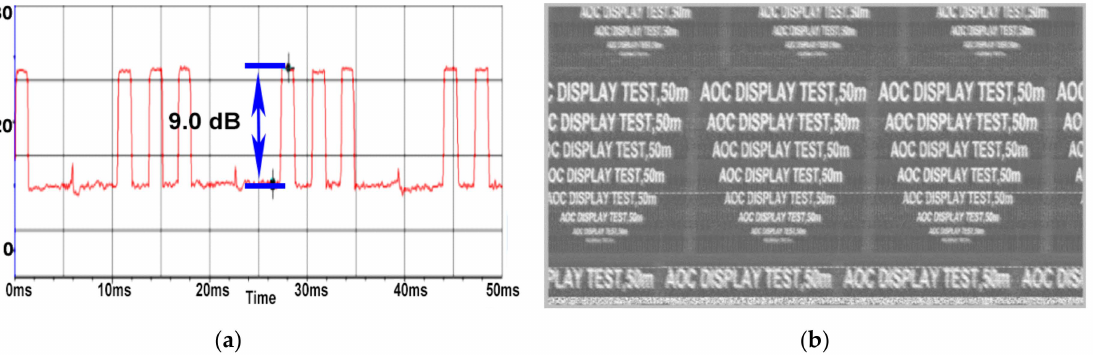
Figure 13. AOC display: ( a ) SNR measured at a distance of 50 m when the cable reel was wound; ( b ) image recovered at a distance of 50 m when the cable reel was